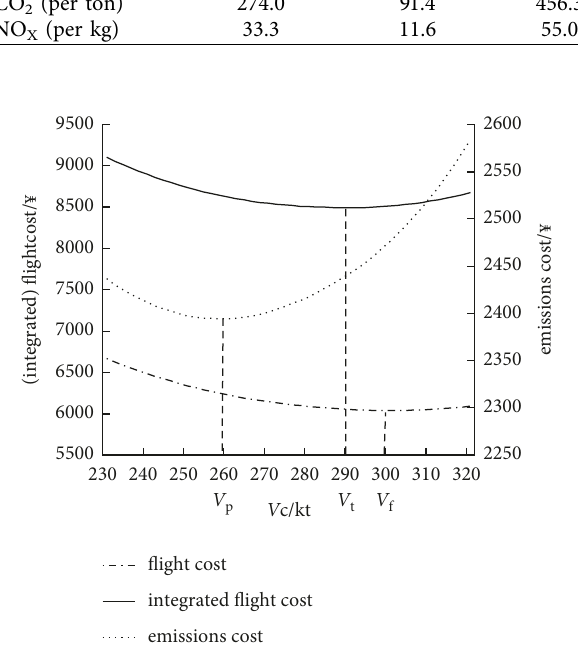
Figure 2: Variation of cost with V